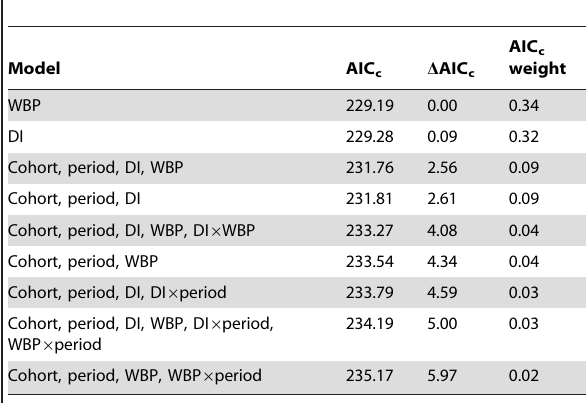
Table 3. Akaike’s Information criteria (AIC c ) of linear mixed- effects models 1 to examine relationships of covariates 2 with home-range size (km 2 ; 95% a -local convex hull) of male grizzly bears in the Greater Yellowstone